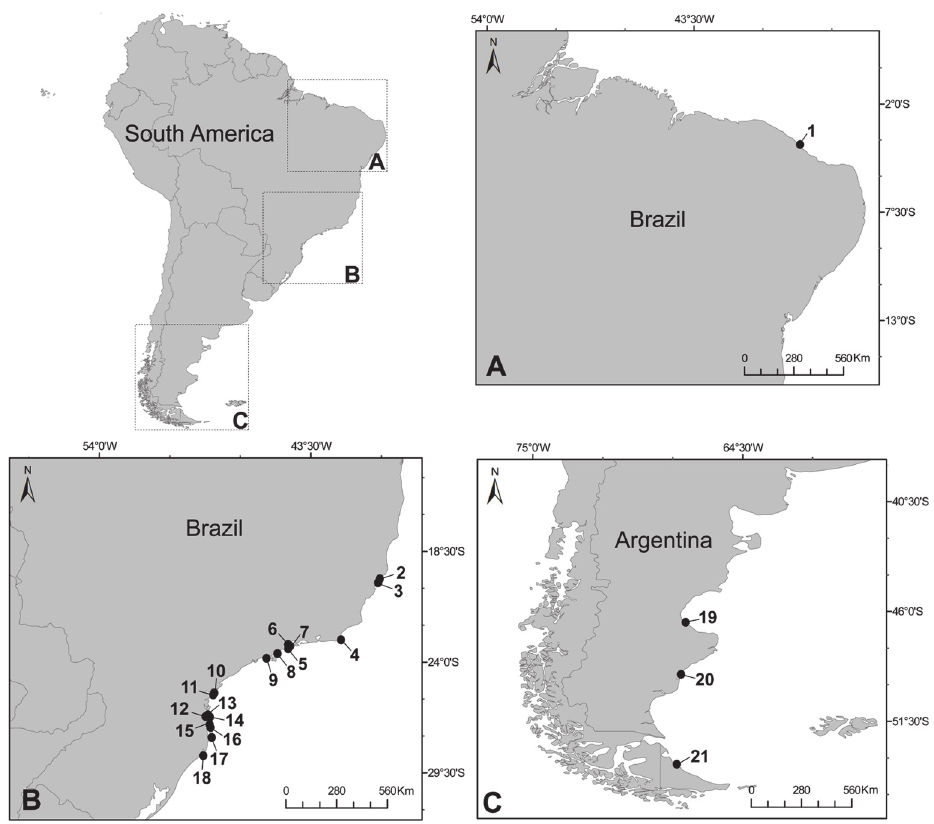
Fig 1. Map of sampling areas in Brazil and Argentina. Circles indicate specific sites were species were sampled. The numbers correspond to the records listed in Table 2.